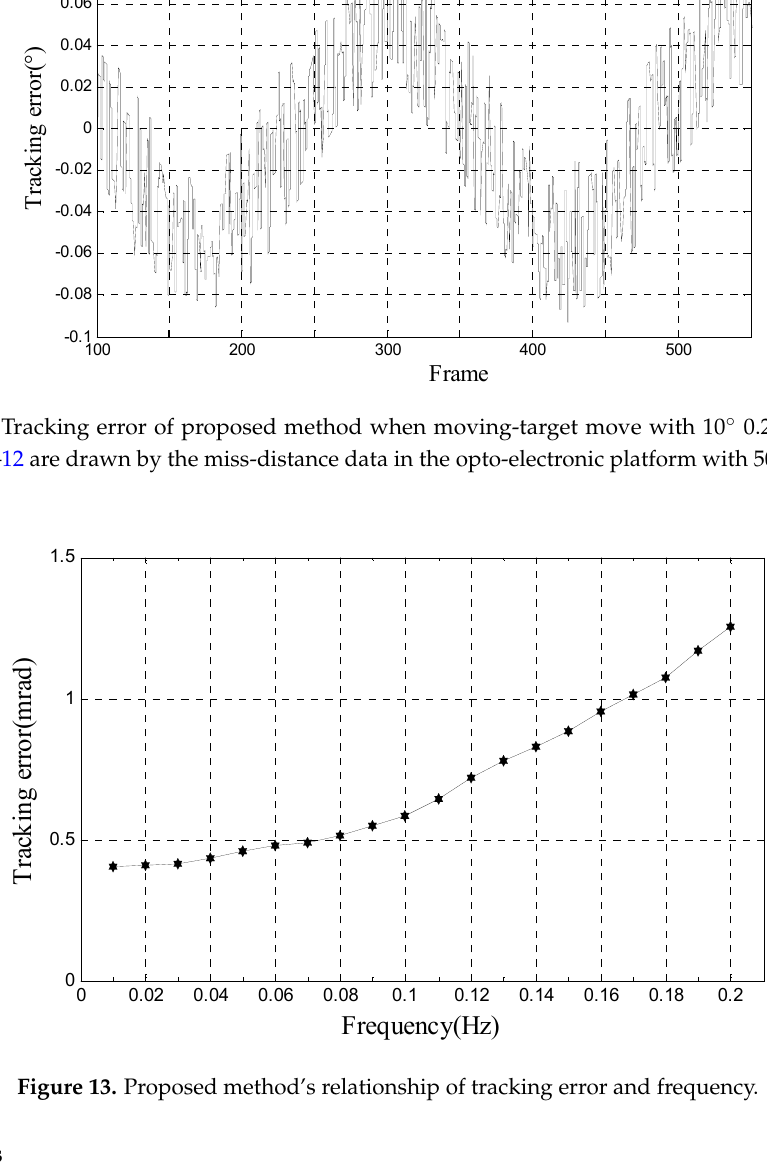
Figure 13. Proposed method’s relationship of tracking error and frequency.